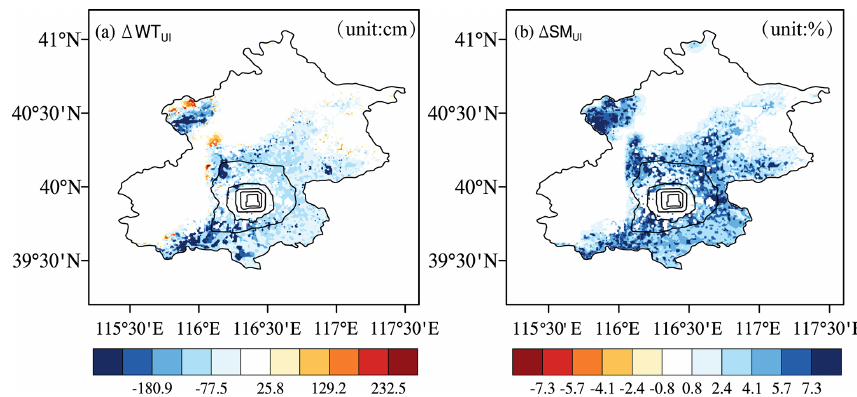
Figure 4. Changes in (a) ground water table and (b) surface soil moisture due to urban irrigation.